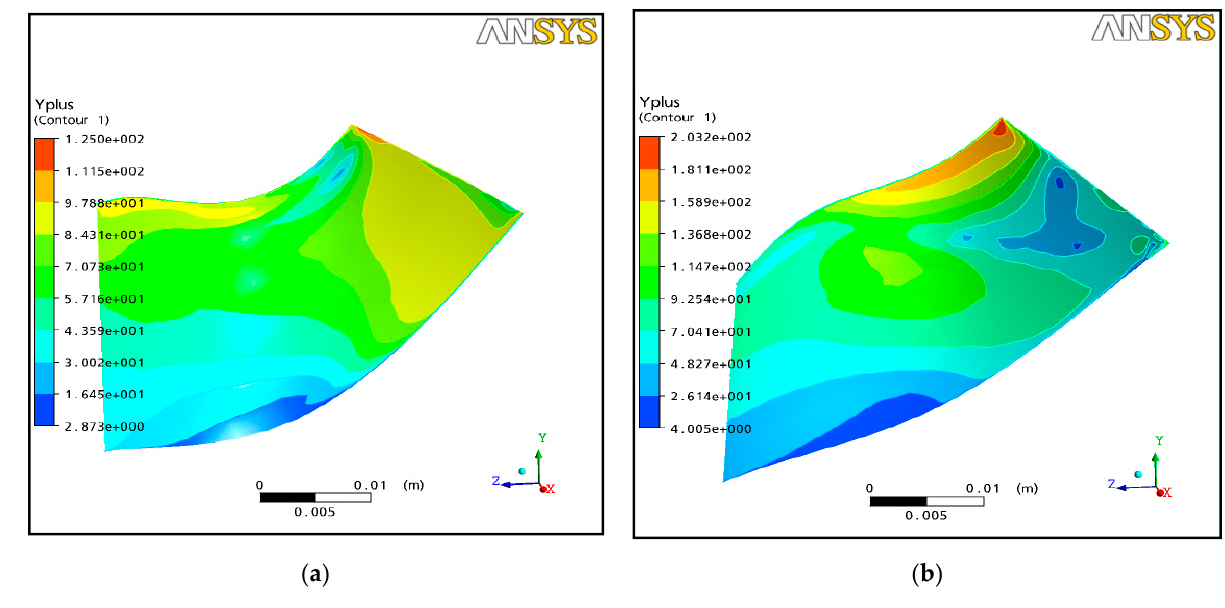
Figure 8. Y+ contours: ( a ) intrados; ( b ) extrados.